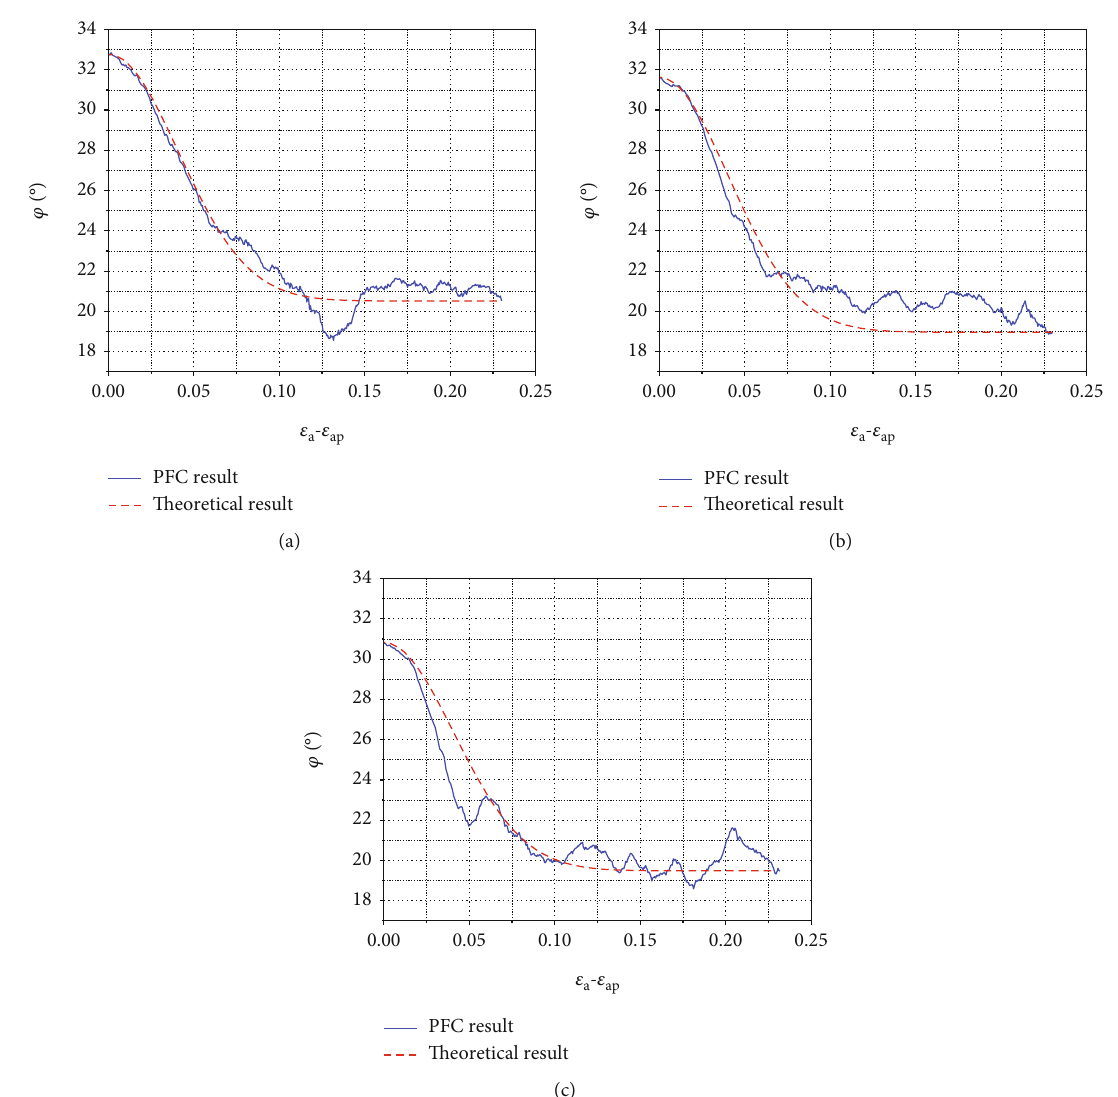
− ε a ap after peak value: (a)